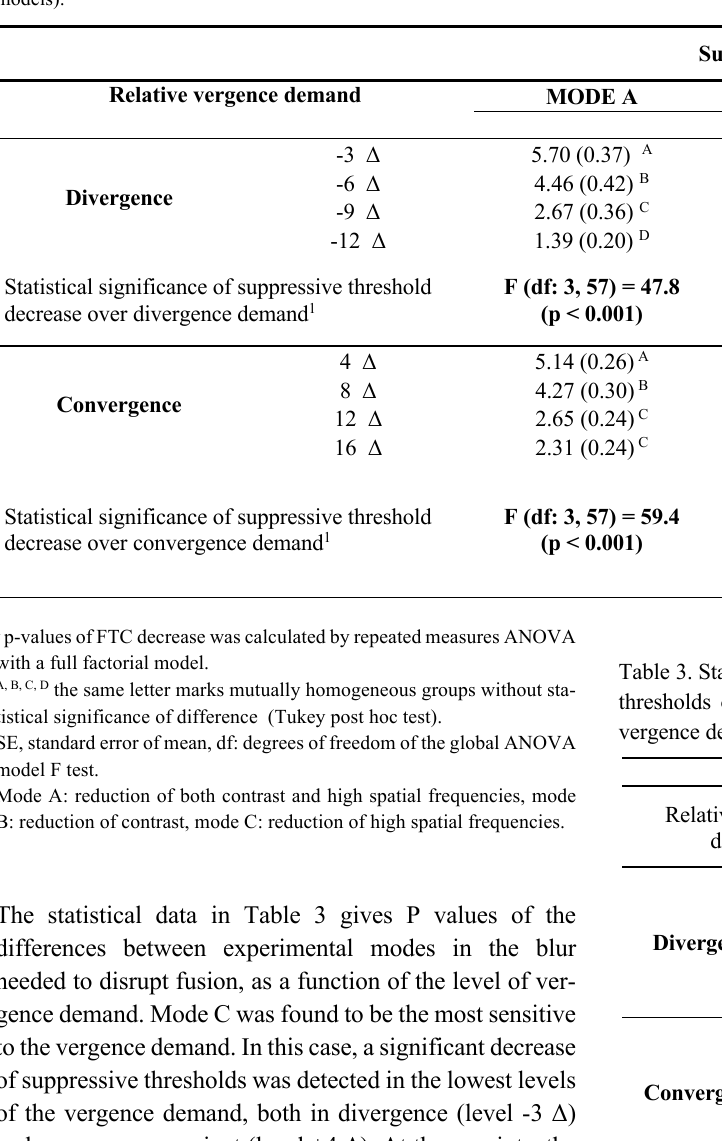
Table 2. Mean suppressive thresholds in relation to vergence demand and mode A, B, C of non-dominant eye image degradation (ANOVA models).